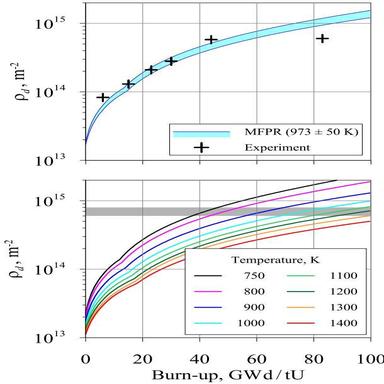
The calculated mean dislocation density, rd, as a function of burnup in comparison with the experimental data at a fixed temperature of 973 ± 50 K (upper panel), and in a wide temperature range from 750 to 1400 K with the limiting interval (grey band) of the dislocation density for the onset of restructuring, 6,1014e8,1014 m-2 (lower panel).